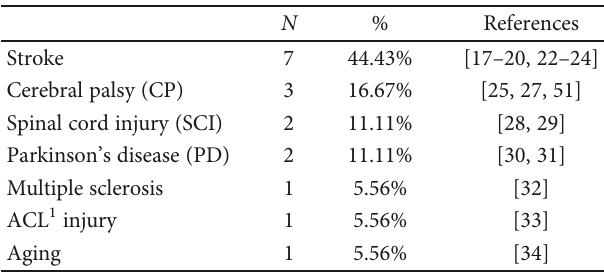
Table 3: Papers using muscle synergies in clinical practice/ rehabilitation for locomotion and balance